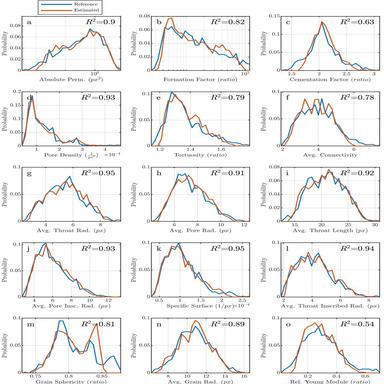
Comparison between the reference and estimated distributions of the 15 single–value features, a to o charts correspond to the features inscribed in 1 rows from 1 to 15.